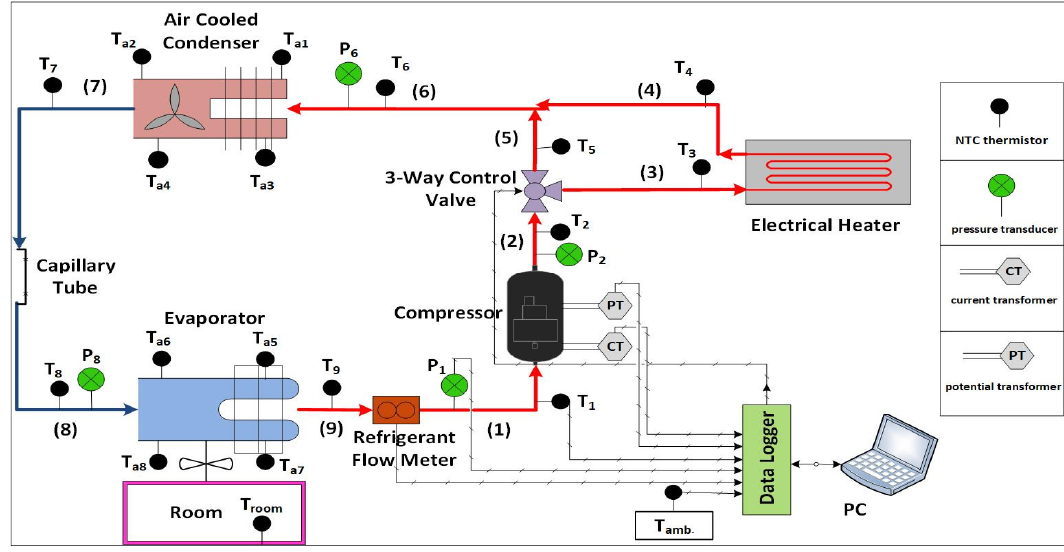
Fig. 1. Schematic diagram of the